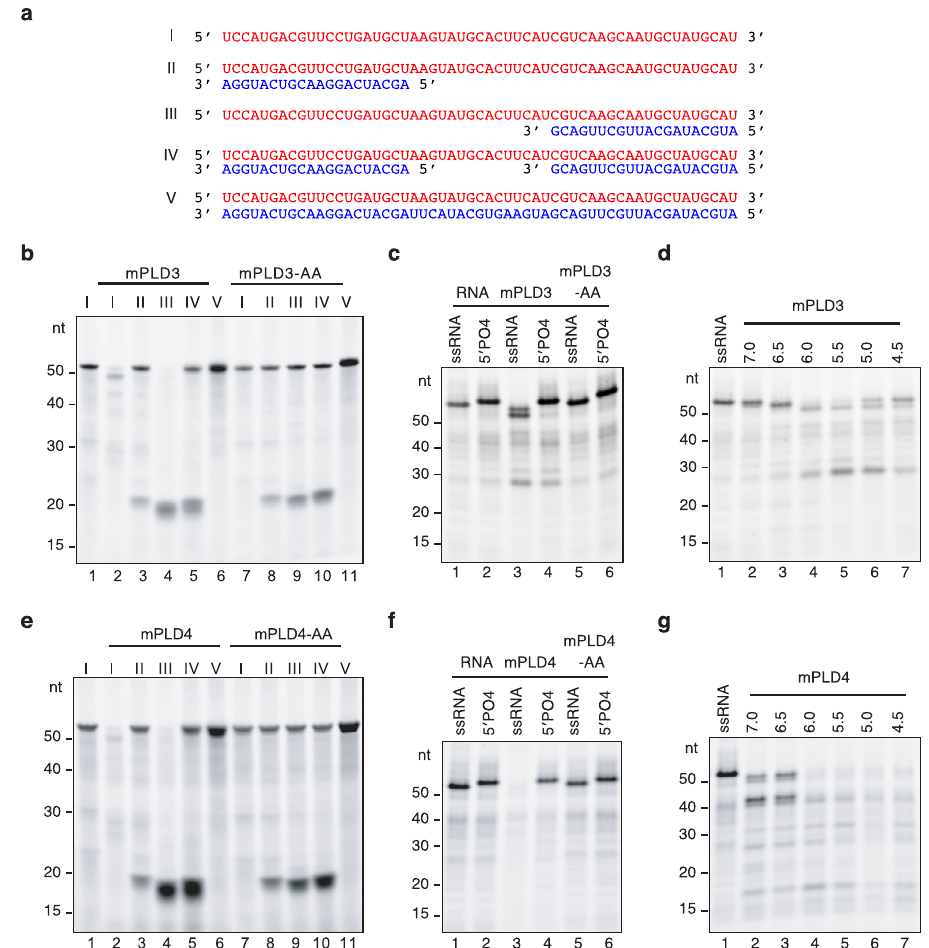
Fig. 3 RNAse activity of PLD3 and PLD4 analyzed on oligonucleotide substrates. a Nucleotide sequences and schematic structures of substrates (I-V) used. The red strand is identical to “ I ” in all substrates and the blue strands are partly or completely complementary, annealed strands. b Denaturing Tris- Borate-EDTA PAGE and SYBR gold visualization of the products of incubation of mouse soluble recombinant PLD3 or enzymatically dead mutant PLD3-AA with the RNA substrates I-V, as indicated above the lanes. c Products of substrate I with or without phosphorylation at the 5 ′ end (5 ′ PO 4 ) digested by mouse PLD3 or PLD3-AA as in b. d PAGE analysis of products of incubation of substrate “ I ” as in ( b ), but with buffers adjusted to a pH of 4.5-7.0. e – g Digestion of RNA by mouse soluble recombinant PLD4 or PLD4-AA control enzyme. These experiments were carried out at least twice with similar